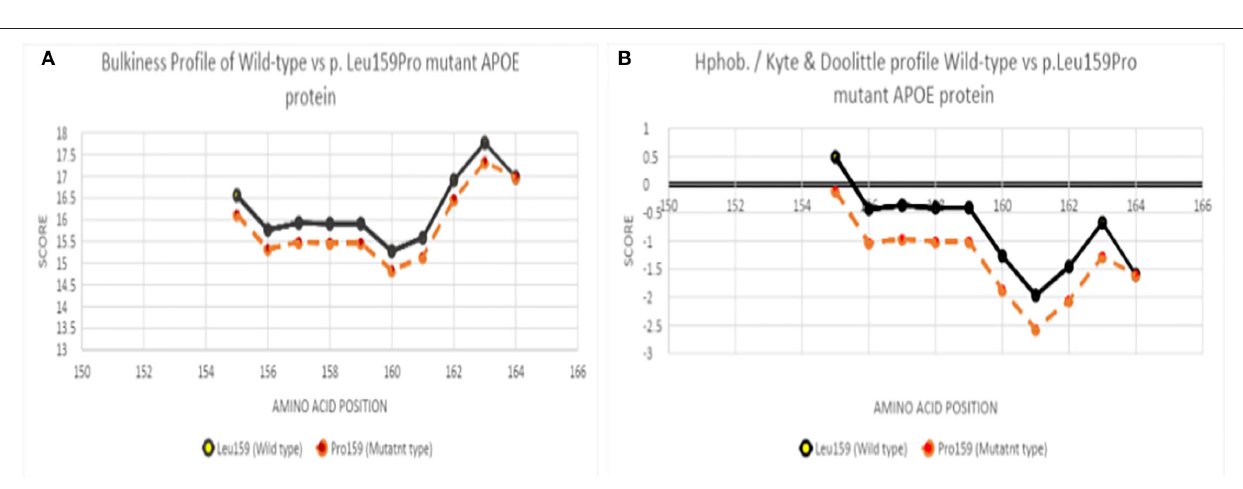
FIGURE 4 | (A) Bulkiness profile of wild-type and Leu159Pro mutant APOE protein, (B) Hydrophobicity profile of wild-type and Leu159Pro APOE mutant